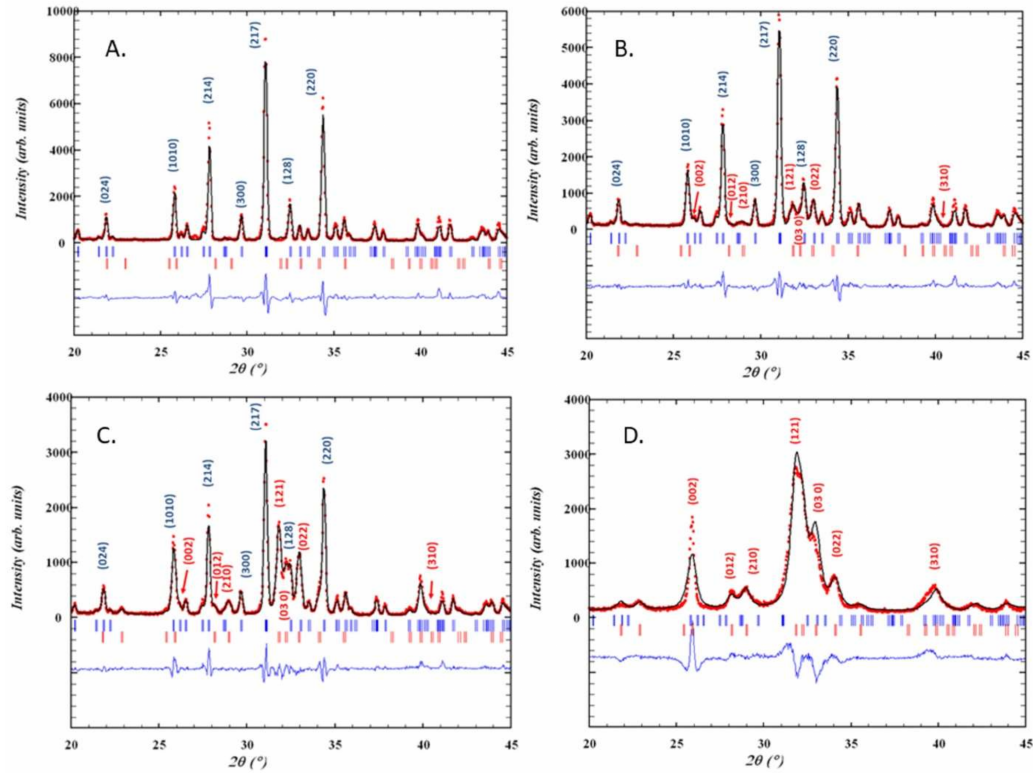
Figure 2. X-ray diffraction patterns of samples 100% β -TCP ( A ), BCP (( B ) 13% HA—87% β -TCP, ( C ) 41% HA—59% β -TCP) and 100% HA ( D ) refined by the Rietveld method. The red points are the experimental points, the continuous black lines correspond to the calculated diagrams, blue and red vertical bars (|) at the bottom indicate the position of the Bragg peaks for the β -TCP and HA phases, respectively. The continuous line at the bottom is the difference between the experimental and theoretical intensity values. Blue Miller index values correspond to TCP and the red ones correspond to